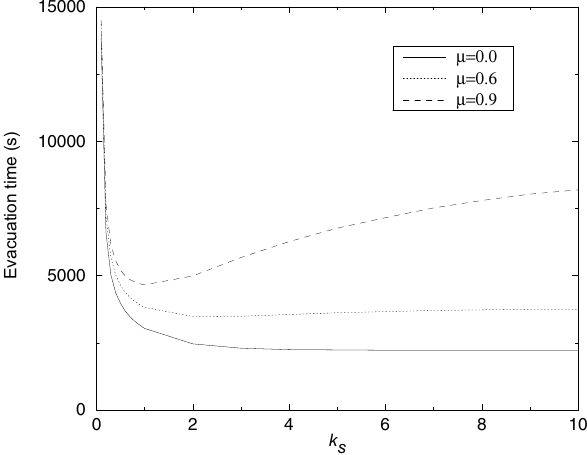
Figure 8 Dependence of evacuation times on the friction parameter µ as a function of k for density ρ S